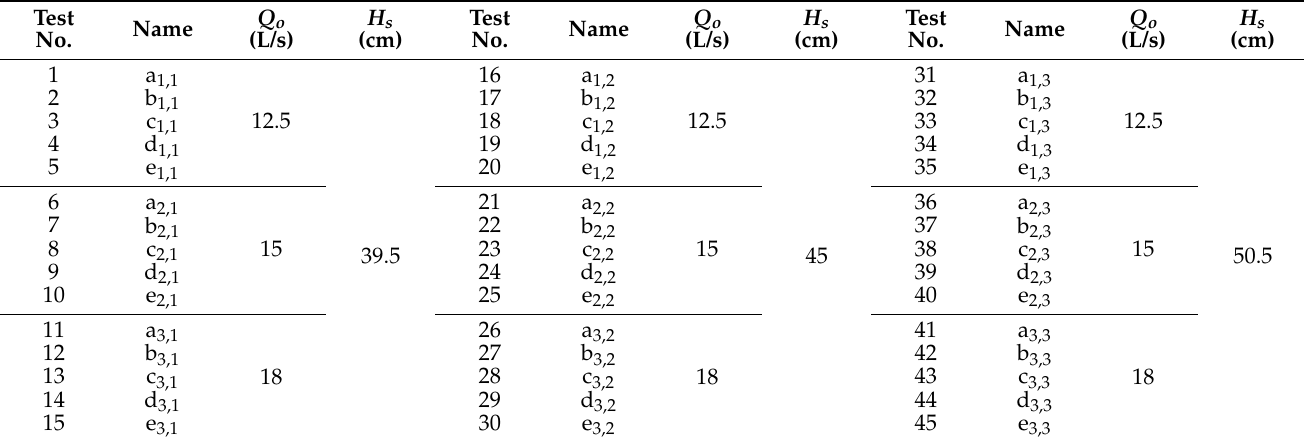
Figure 2. Schematic representation of the structures used in the current research. Table 2. Experimental setup in the current research